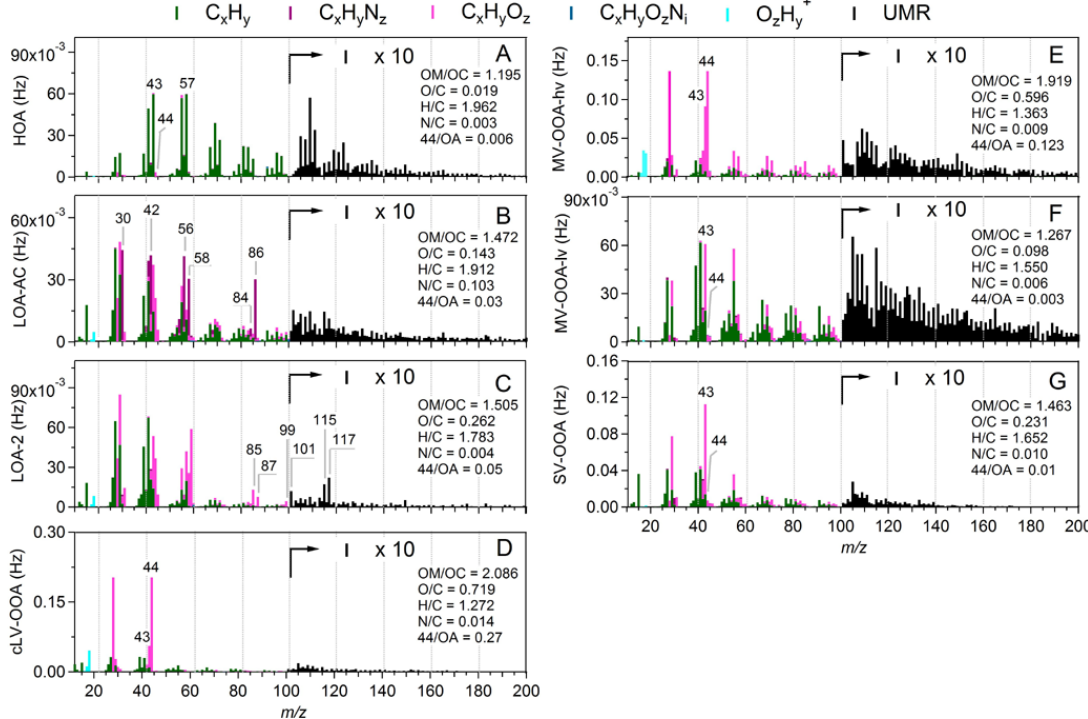
Fig. 7. Mass spectra of OA components identified from the 7-component TD-AMS-PMF solution. The intensity of unit-mass-resolution signals > m/z 100 have been adjusted to clearly show structure in this range. EA results and f 44 for each identified component have also been